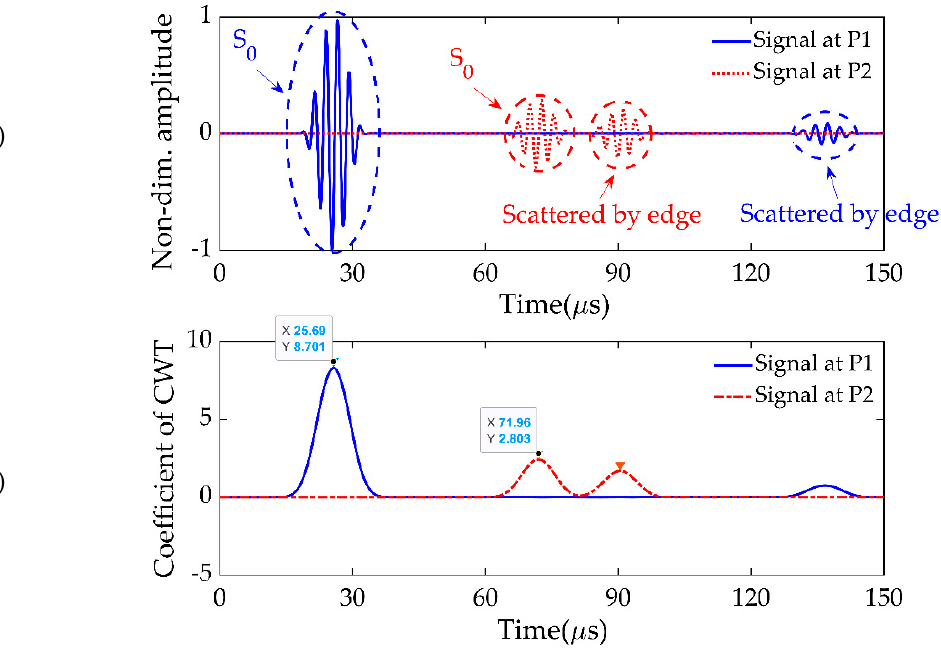
Figure 5. ( a ) Signals received at P1 and P2. ( b ) Continuous wavelet transformation (CWT) of signals received at P1 and P2.